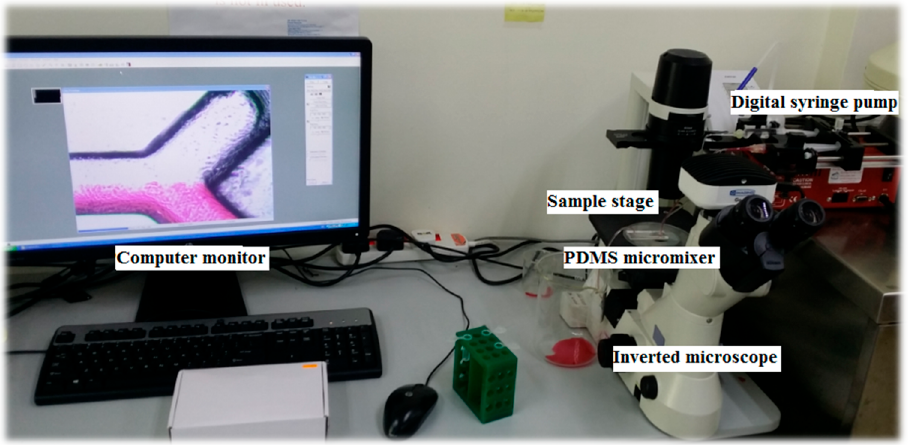
Figure 4. Experimental setup for photometric experiment.